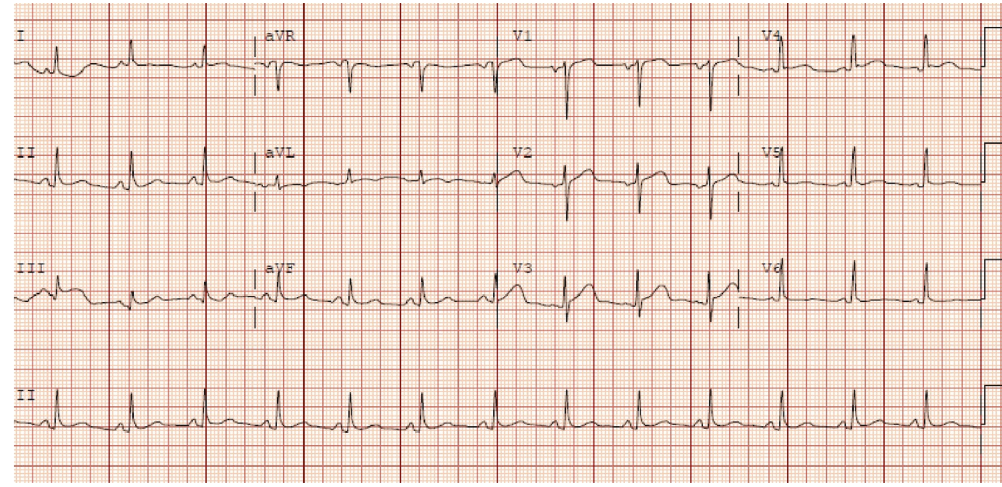
Figure 2:12-lead electrocardiogram obtained 15 hours after presentation showing persistence of the STelevations with PR depressions in all leads, except in aVR which showed ST depression and PR elevation.